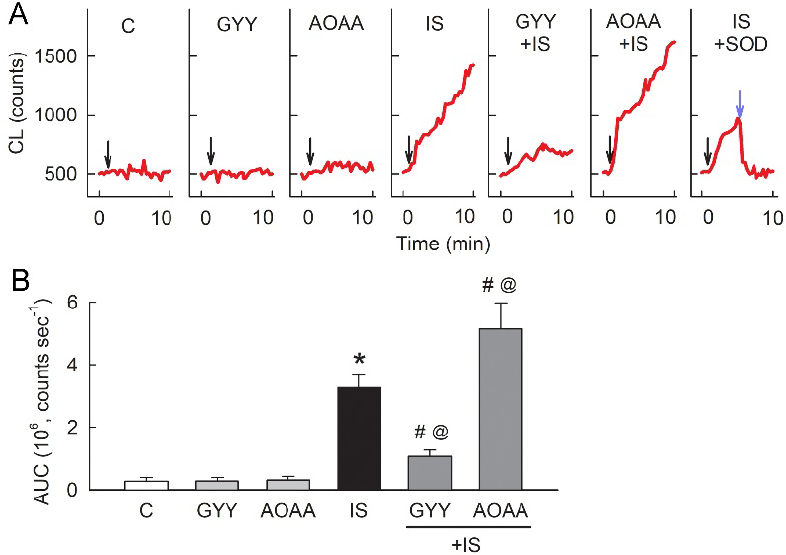
Figure 8. Supplementation with H 2 S reduces IS-induced superoxide formation. ( A ) The representa- tive tracings show changes in chemiluminescence (CL) in the culture medium after 48 h of treatment with the vehicle solution (control, C), 10 mM IS, 50 µ M GYY-4173 (GYY), or 100 µ M AOAA alone, or in combination. The black arrows indicate lucigenin injection after 1 min of baseline recording. In the rightmost tracing, SOD treatment (200 mU as indicated by a light blue arrow) decreased CL in cells treated with IS for 48 h, which confirms that the CL recordings of lucigenin are derived from superoxide. ( B ) The bar graph shows the total amount of CL as the area under the curve (AUC). N = 6 in each group. Note that IS-induced superoxide formation was attenuated by the H 2 S donor GYY-4173 and enhanced by the inhibition of endogenous H 2 S production via AOAA. * p < 0.05, IS vs. control ( C ) group; @ p < 0.05, drug + IS vs. IS group; # p < 0.05, drug + IS vs. drug only group.